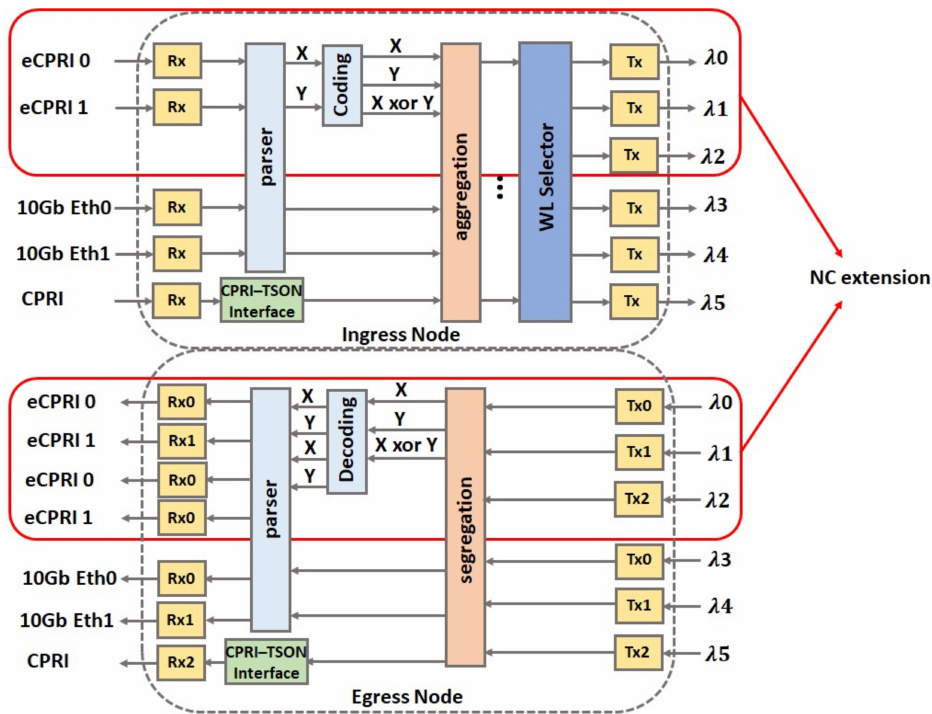
Figure 9. The TSON data plane architecture supporting